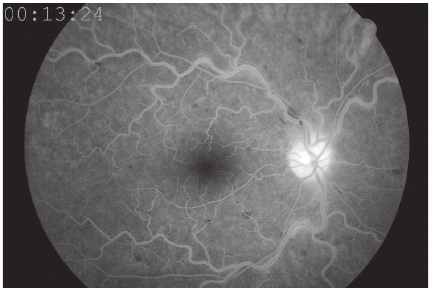
Figure 2: Fundus fluorescein angiography shows no ischemic